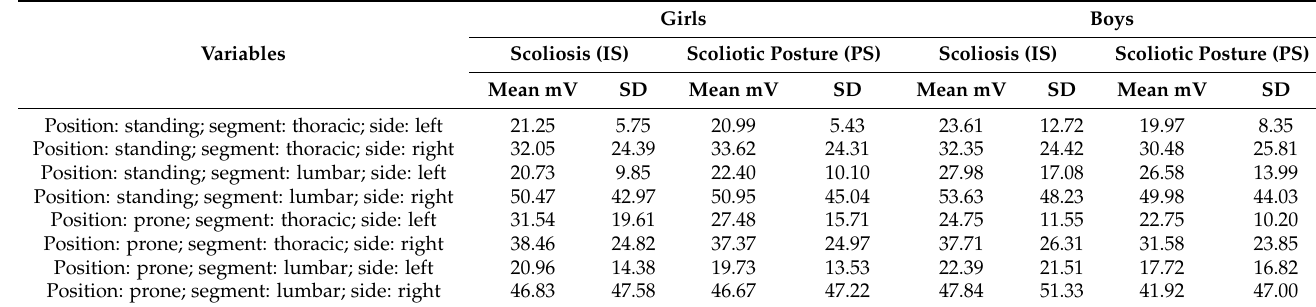
Table 1. Muscle tone of the erector spinae (sEMG amplitude).